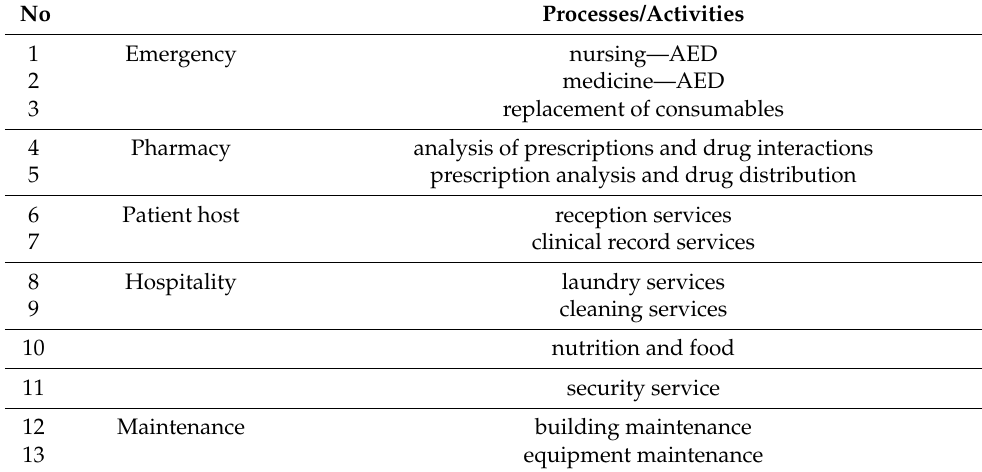
Table 3. Interviews designated by the focus on